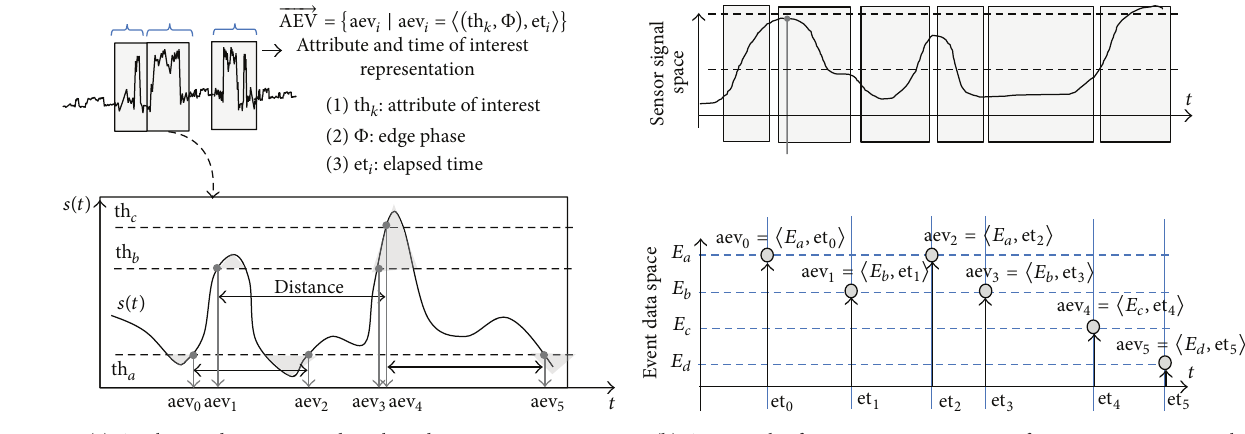
Figure 2: Event-space quantization and accuracy-configurable event-driven sensor processing flow.